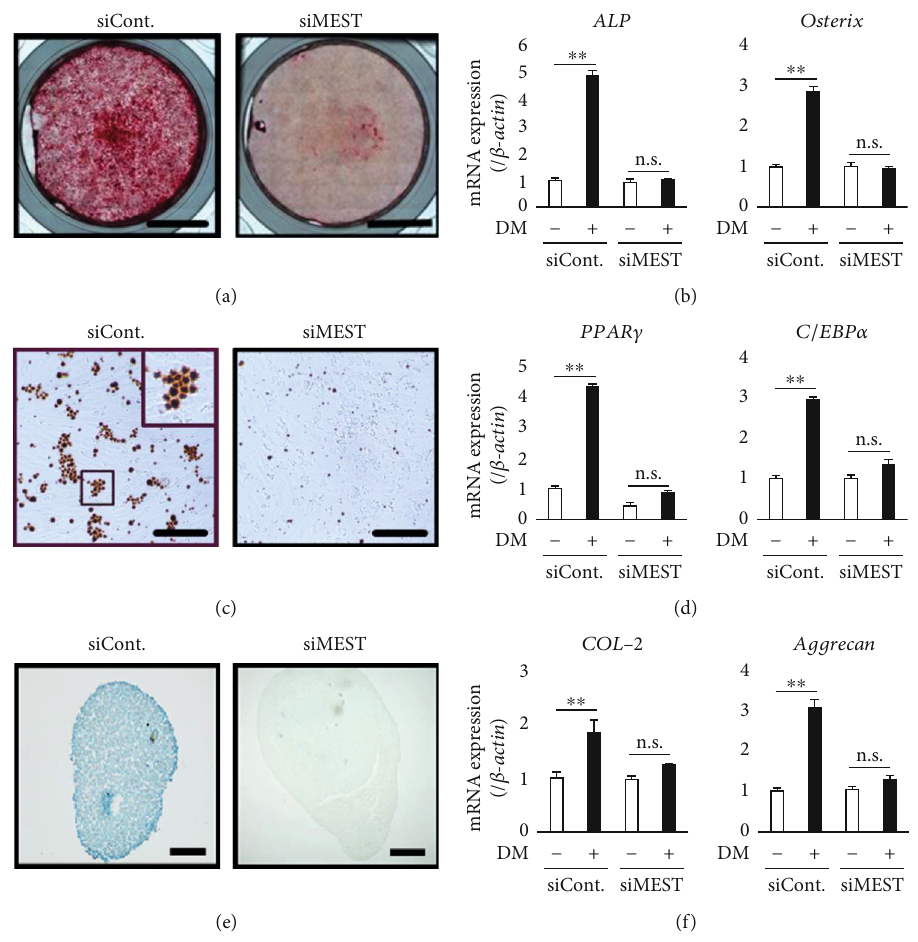
Figure 4: The e ff ects of MEST knockdown on the multidi ff erentiation capacity in 2-23 cells. (a) The formation of mineralized nodules in 2-23 cells transfected with control siRNA (siCont.) or MEST siRNA (siMEST) was examined by Alizarin red S staining after culture in osteoblastic di ff erentiation medium (DM) for 3 weeks (bars: 5mm). (b) The gene expression of ALP and Osterix in 2-23 cells transfected with siCont. or siMEST, which were cultured with or without DM for 3 days, was assessed by quantitative RT-PCR. (c) The lipid vacuoles in 2-23 cells transfected with siCont. or siMEST were examined by Oil red O staining after culture in adipogenic DM for 3 weeks (bars: 20 μ m). (d) The gene expression of PPAR γ and C/EBP α in 2-23 cells transfected with siCont. or siMEST, which were cultured with or without DM for 3 days, was assessed by quantitative RT-PCR. (e) The cartilaginous matrix in 2-23 cells transfected with siCont. or siMEST was examined by Alcian blue staining after culture in chondrogenic DM for 4 weeks (bars: 200 μ m). (f) The gene expression of Type-2 collagen ( COL-2 ) and Aggrecan in 2-23 cells transfected with siCont. or siMEST, which were cultured with or without DM for 3 days, was assessed by quantitative RT-PCR. (b, d, f) In quantitative RT-PCR, the expression levels of these genes were normalized against β -actin expression. All values are means ± S : D : (error bars) of quadruplicate assays. ∗∗ p < 0 : 01 . n.s.: not signi fi